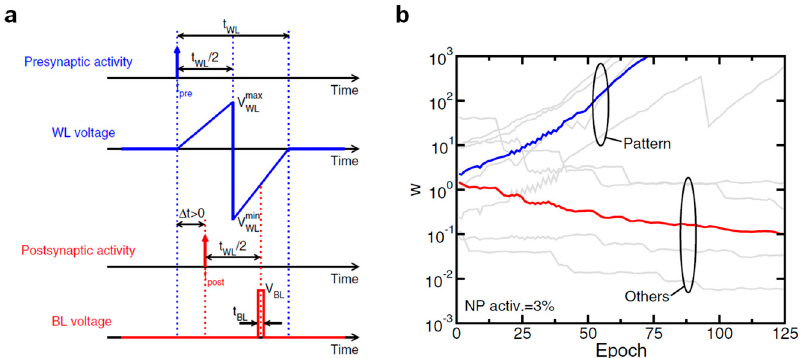
Figure 10. ( a ) Pulse scheme proposed to implement the spike-timing-dependent plasticity (STDP) waveform exploiting the erase mechanism shown in Figure 9b and ( b ) evolution of the weights of the implemented NOR Flash-based spiking neural network during the learning phase. Reprinted with permission from [57]. Copyright 2018,